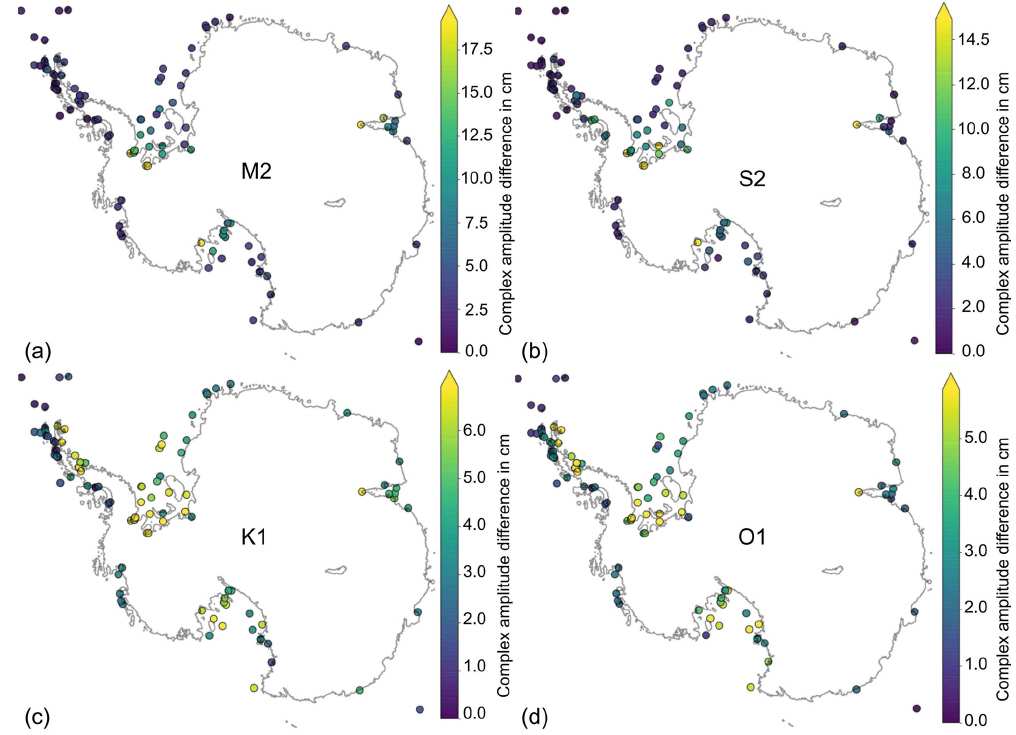
Figure D4. Spatial distributions of tidal height accuracy. Complex amplitude differences between the model solution and Antarctic tide gauge records are shown for the major tidal constituents (a) M2, (b) S2, (c) K1, and (d) O1. The largest biases occur at the deep grounding lines of the large ice shelves, where the water column thickness is